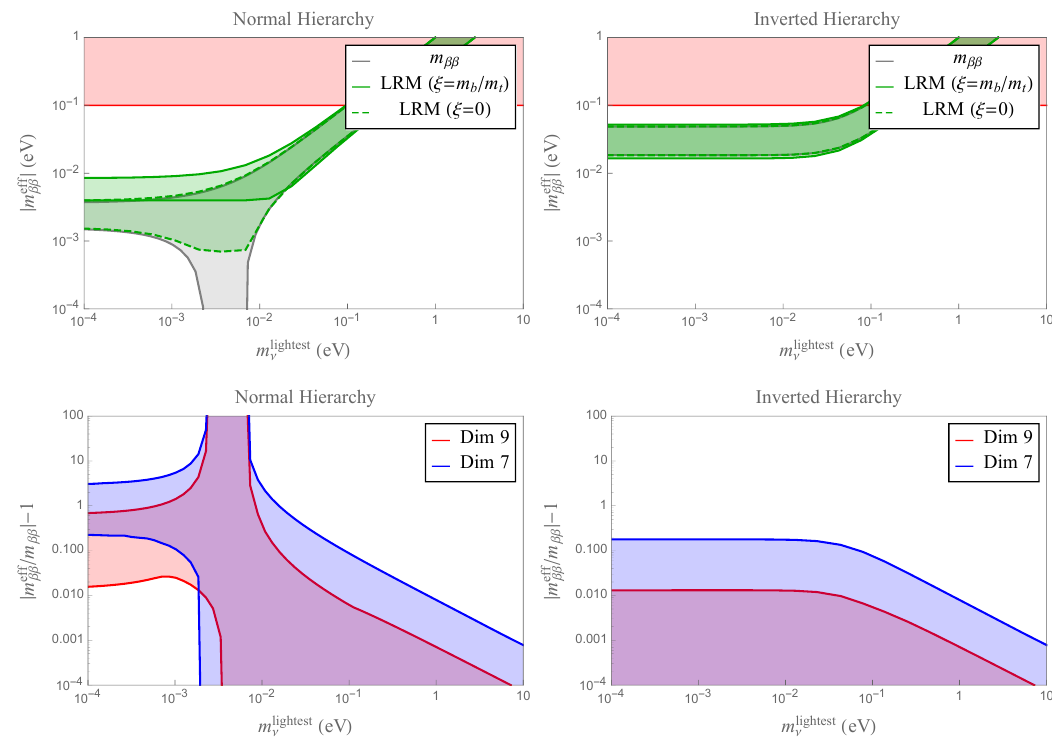
Figure 4 . Same as (cid:12)gure 3, now with the choice of the model parameters in eq. (6.21).